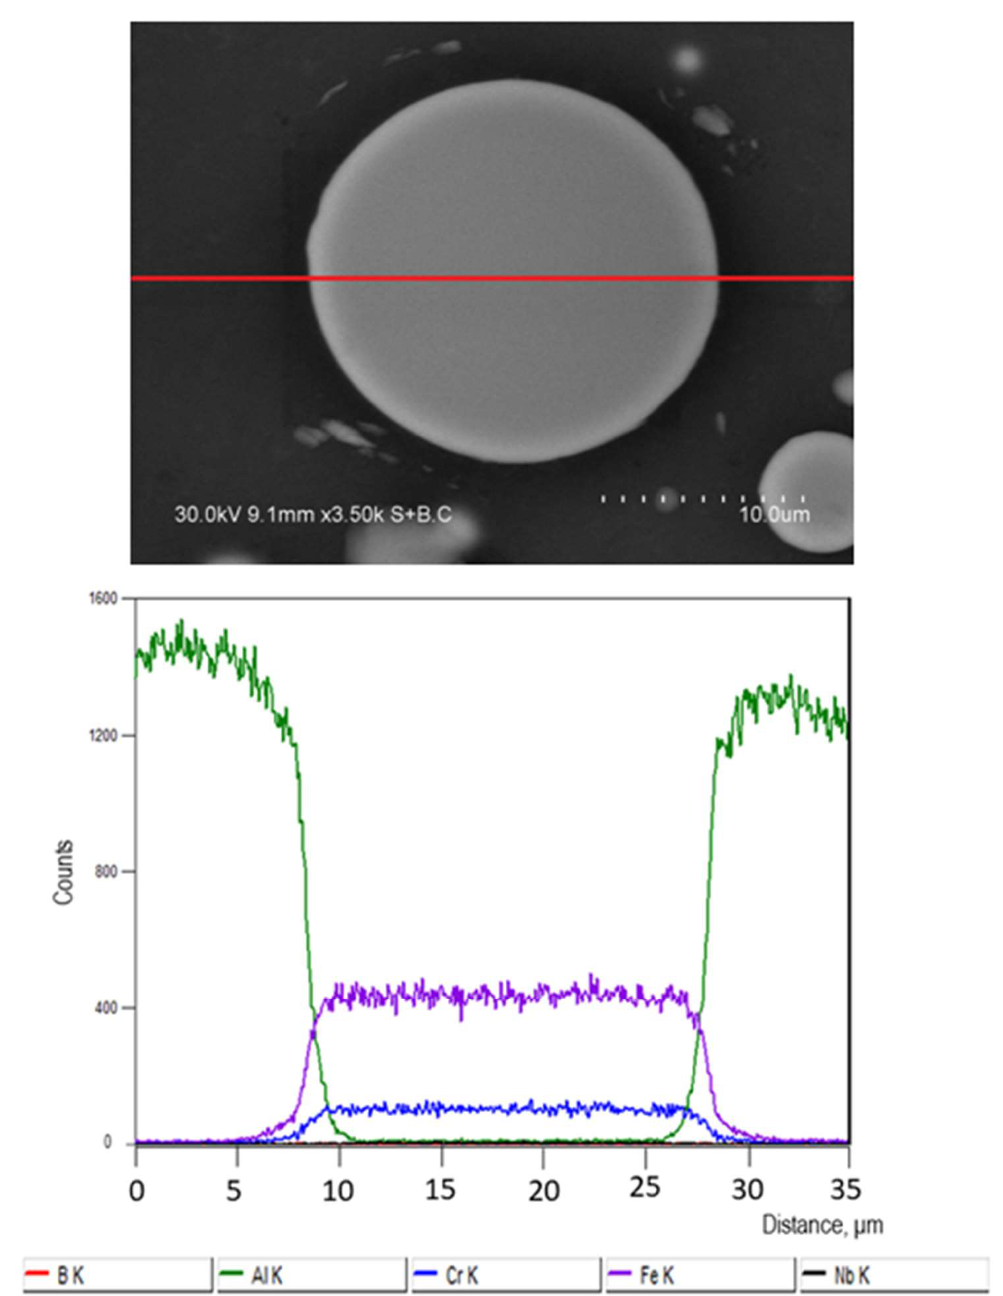
Figure 5. Fe-based alloy particle in an Al matrix, composite sintered at 540 ◦ C, no holding, and results of the energy-dispersive spectroscopy (EDS) analysis along the red line on the image. The compression true stress-true strain curves are presented in Figure 7. The sintered and sintered/forged Al-20 vol.% Fe 66 Cr 10 Nb 5 B 19 composites having no reaction layer